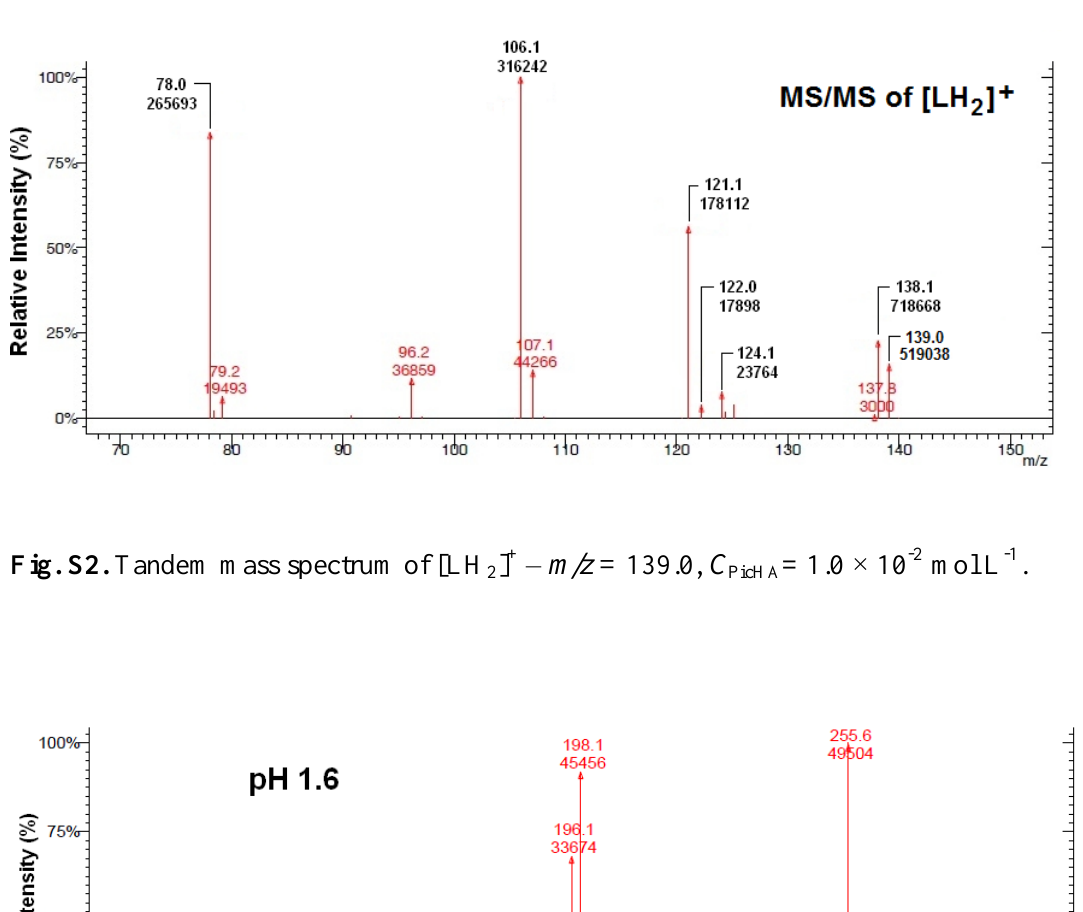
/PicHA 3 = 2.5 × 10 -4 mol L -1 . Fe(III)